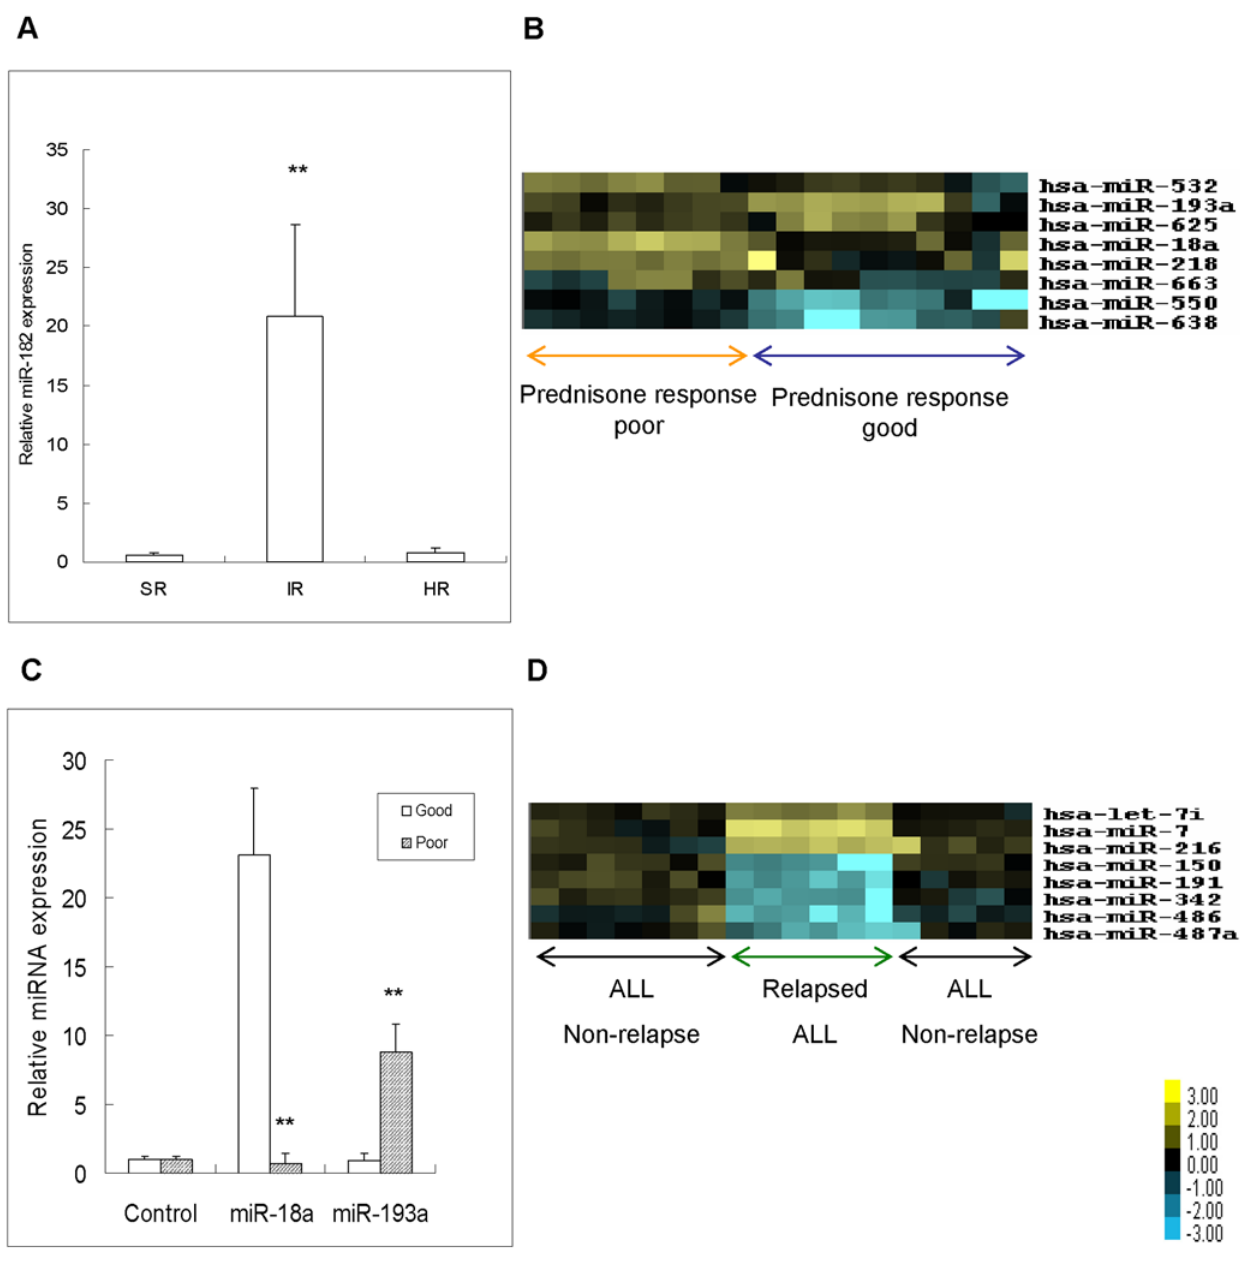
Figure 3. MiRNA expressions associated withz risk group, response to prednisone and relapse in ALL subtypes. (A) MiR-182 was highly expressed in IR groups of ALL (p=0.000) was confirmed by qRT-PCR using the validation cohort; (B) MiRNA expression pattern of pediatric ALL associated with responses to prednisone treatment Pediatric ALL; (C) Differentially expressed miR-18a (p=0.000) and miR-193a (p=0.001) in ALL patients with different responses to prednisone treatment were validated by qRT-PCR using the validation cohort; (D)MiRNA expression pattern in the relapse and non-relapse of pediatric ALL. *p , 0.05, **p , 0.01.